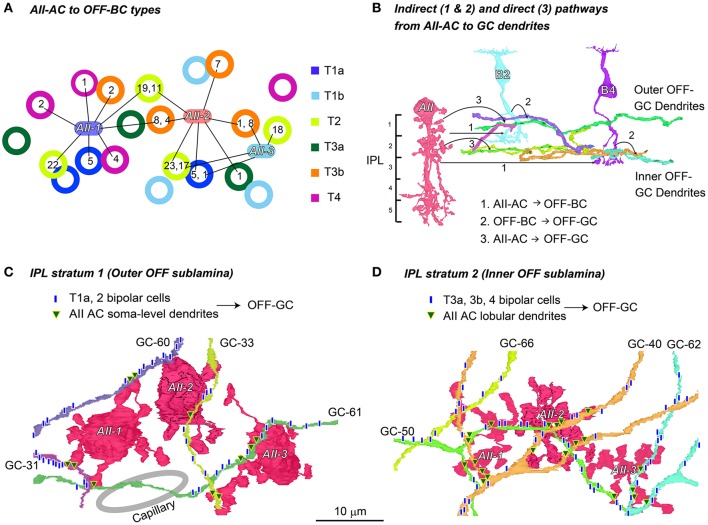
Two stratification levels for output to OFF ganglion cell dendrites from AII amacrine cells. (A) The number of synapses (shown in circles) from three AII amacrine cells (AII-1, −2, and −3) to different types of bipolar cells (labeled in different colors). (B) An illustration showing that both indirect (1 and 2: AII-AC → OFF-BC → OFF-GC) and direct (3: AII-AC → OFF-GC) pathways are implemented in either stratum 1 or stratum 2. (C) In stratum 1 of the IPL, dendrites of a group of ganglion cells contacted the soma-level dendrites of AII amacrine cells and the axon terminals of T1a and T2 cells. (D) In stratum 2 of the IPL, the dendrites of the other group of ganglion cells contacted the lobular dendrites of AII amacrine cells and the axon terminals of T3a, T3b, and T4 cells.